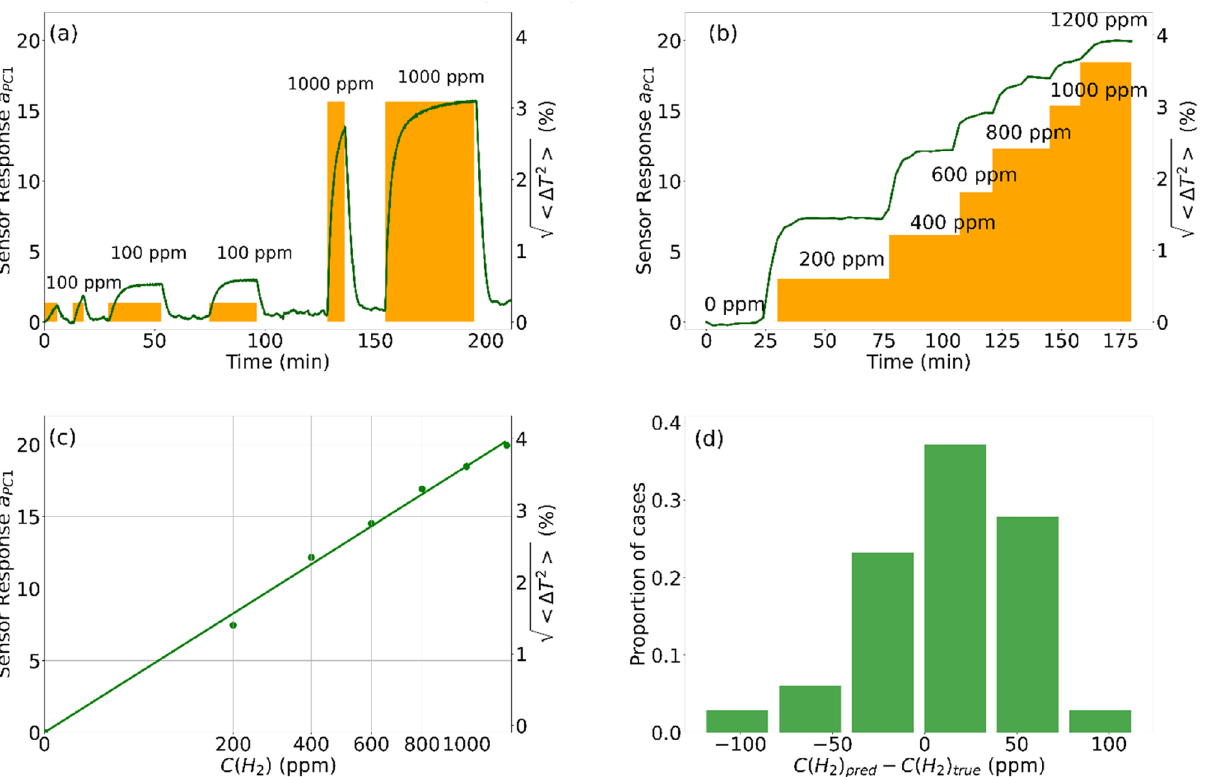
Figure 4. Response of the sensor to 100 ppm and 1000 ppm of hydrogen switched on and off ( a ) and to a “ladder” of hydrogen concentrations increased from 200 to 1200 ppm in air ( b ). ( c ) Dependence of the sensor response on the hydrogen concentration in air; shown versus the square root scale for hydrogen concentrations. ( d ) Resulting error